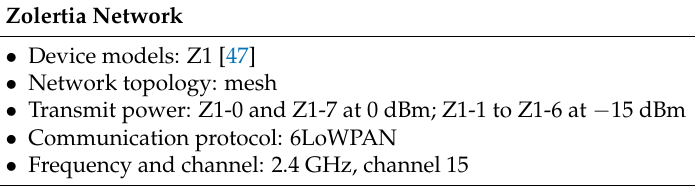
Table 1. Details of the